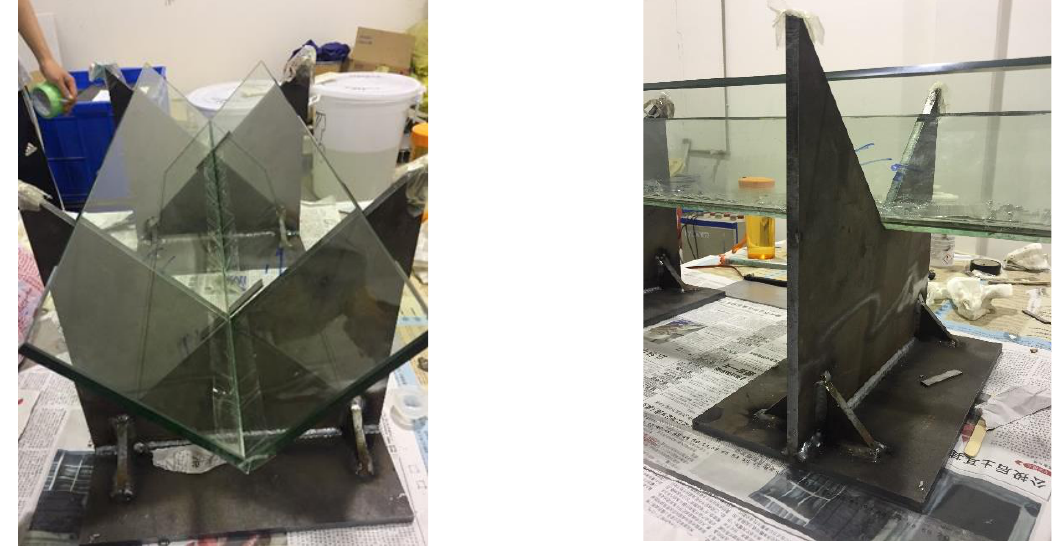
Fig. 2 The assembling of specimens.